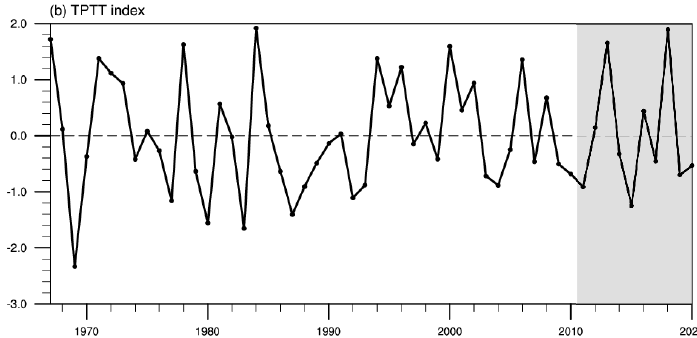
Figure 1. The eddy tropospheric temperature of 200 – 500 hPa in boreal summer. The blue box indicates the region of the TPTT index ( a ). The detrended standardized TPTT sequence. The gray shading indicates the test dataset, and the white background is the training dataset ( b ).